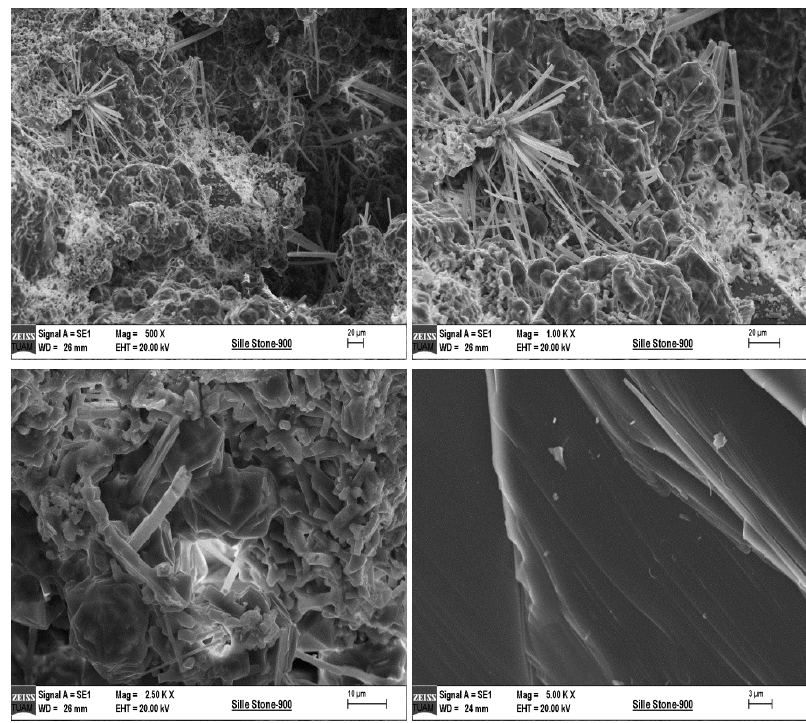
Figure 8. SEM micrographs of heat treated-Sille stone at 900 °C Figure 8: SEM micrographs of heat treated-Sille stone at